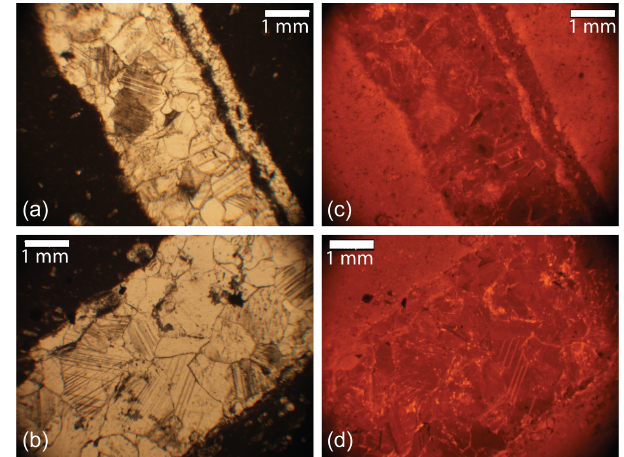
Figure 3. (a, b) Photomicrographs of various veins in plain polar- ized light, (c, d) with corresponding view under cathodolumines- cence; top one is a set J1 vein from the Scaglia Fm., while the bot- tom one is a set J2 from the Maiolica